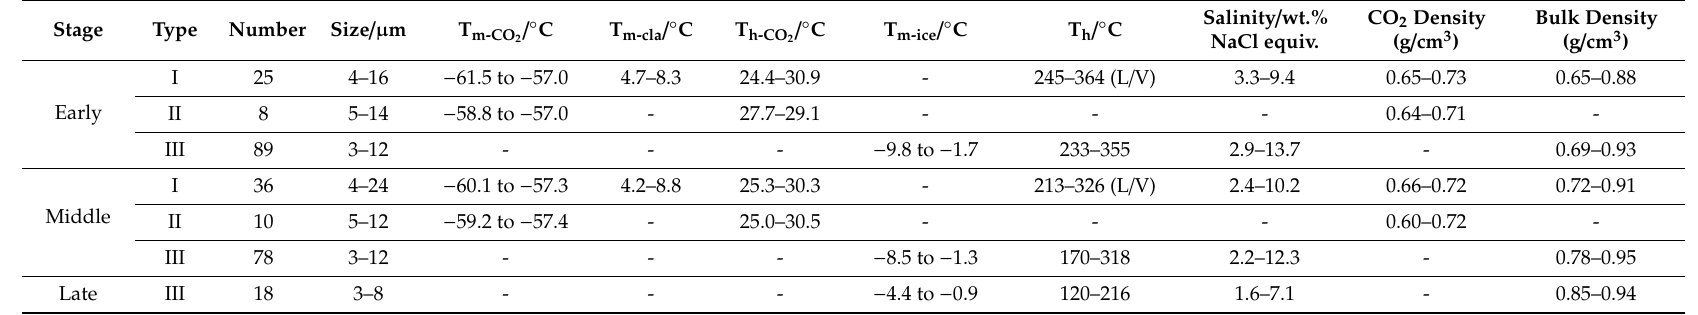
Table 1. Microthermometric data for fluid inclusions from the di ff erent stages analyzed in this